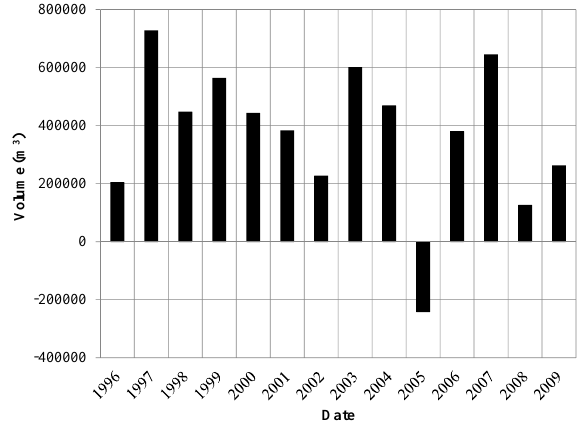
Fig. 7. Profile area recovery period shown by the bar graph and recovery rate shown by the line